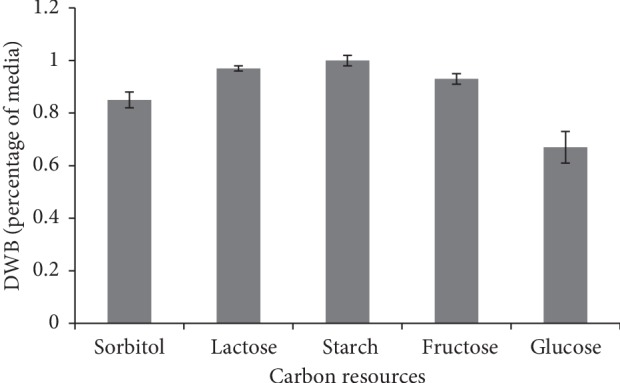
Effect of various carbon sources on DWB.